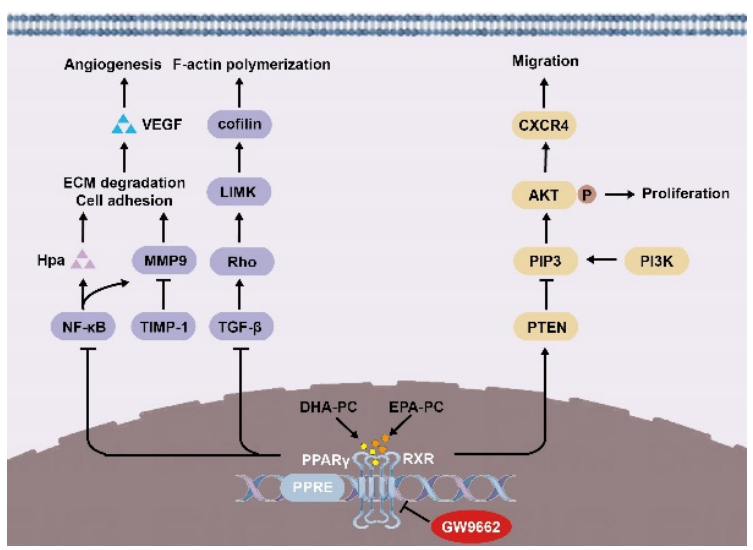
Figure 9. Schematic representation of the mechanisms by DHA-PC and EPA-PC suppresses 95D cells metastasis.